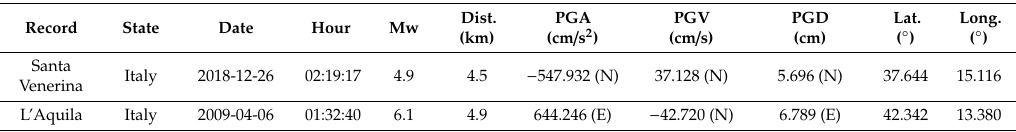
Figure 5. Accelerograms of ( a ) Santa Venerina (2018) and ( b ) L’Aquila (2009). Table 1. Records adopted in numerical